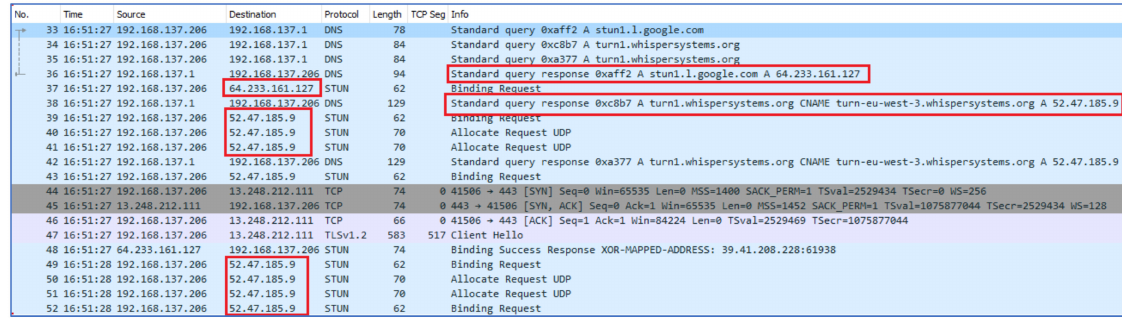
Figure 9. STUN and TURN servers during call initiated by User A.